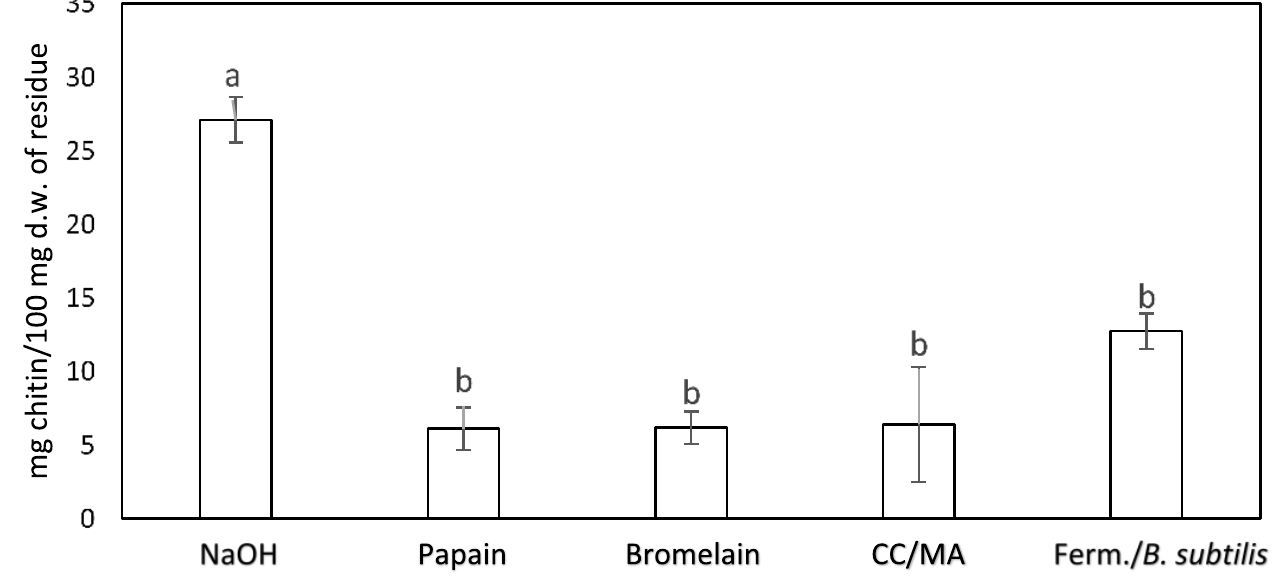
Figure 3. Chitin content (mg/100 mg d.w.) of solid residues obtained after different deproteinization processes or one-step processes for chitin isolation. Error bars indicate the standard error based on the variation in the chitin content. Different subscript letters indicate significant differences ( p < 0.05) among the means of the chitin content determined for each sample.